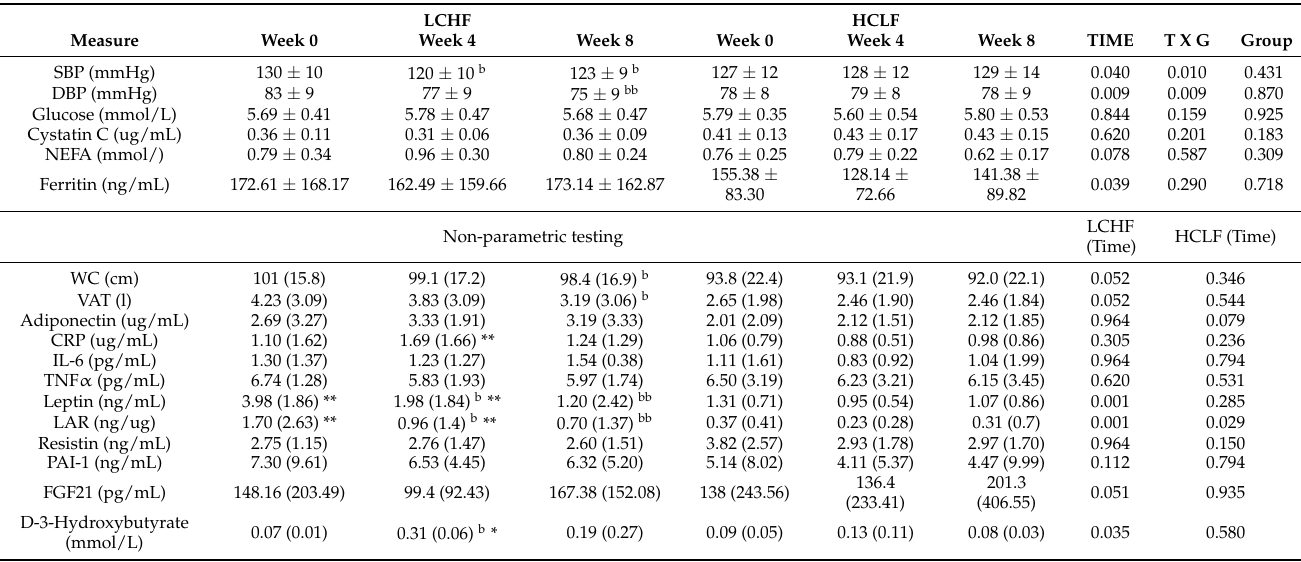
Table 2. Changes in anthropometric variables and biochemical markers of metabolic health following the LCHF and HCLF diets for 8